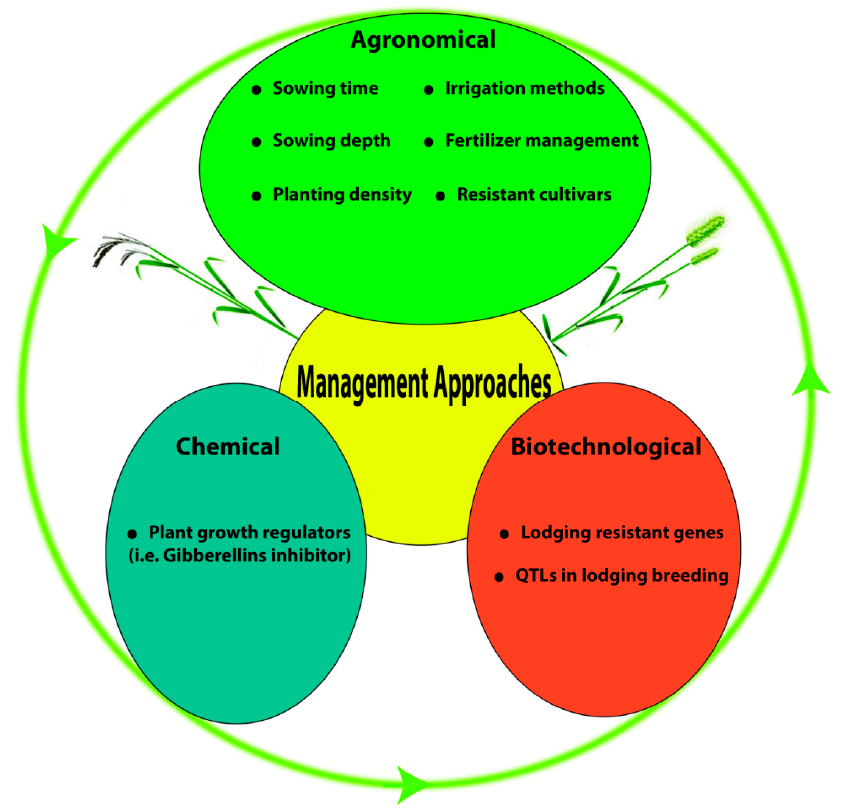
Figure 5. Summary of the most appropriate ways including molecular breeding strategies, chemical control, and agronomical management approaches applying to mitigate field lodging.